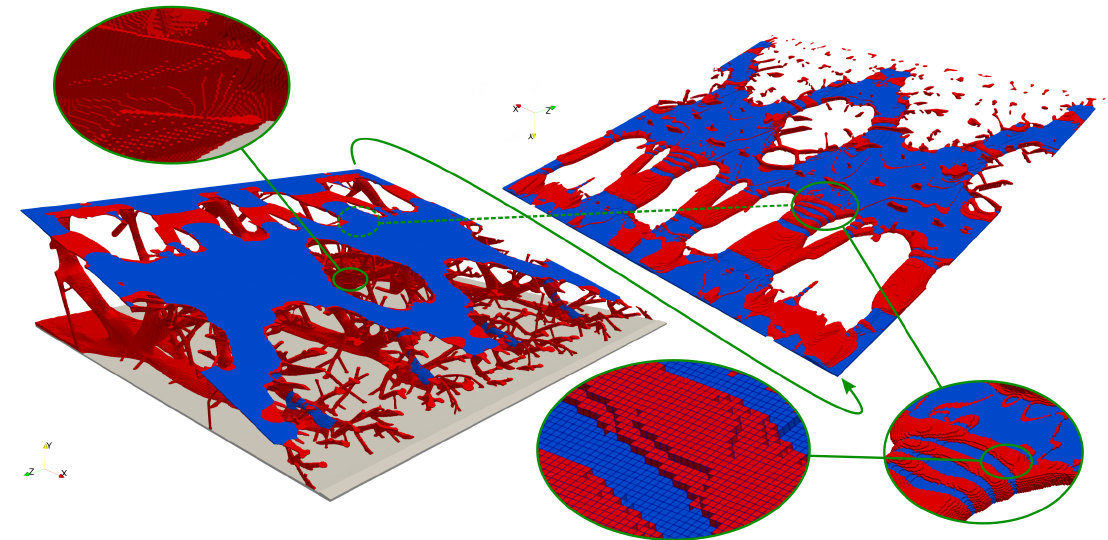
Figure 4. Isometric view of the resulting topology from the density approach with one design domain. The skin on the top side is removed for viewing the internal structure. The field is realized with a threshold value of 0.5. On the right side of the figure, a slice of the bottom side of the actuator portion is shown; notice the level of detail achieved with the fine mesh discretization. In the top left corner, merging, plate-like, and truss structures are